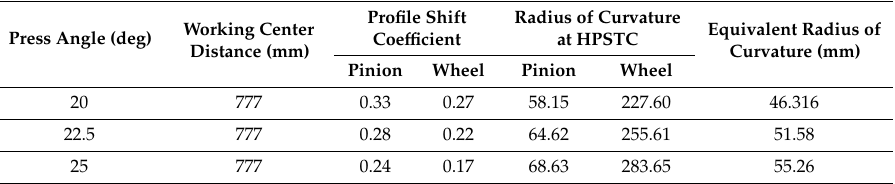
Table 2. Parameter combination of different equivalent radii of curvature.